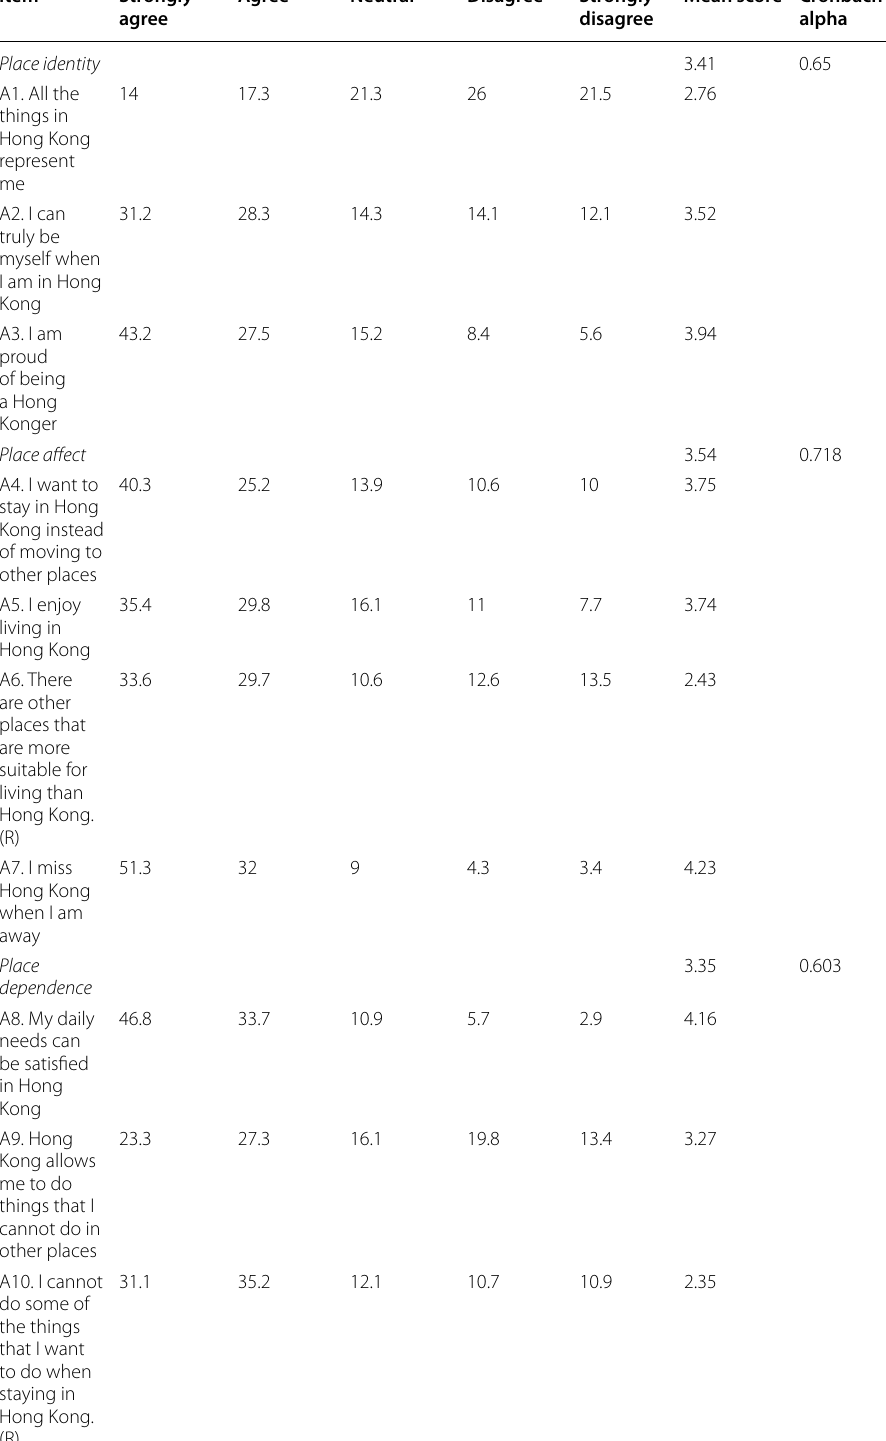
Table 2 Distribution of responses in questionnaire